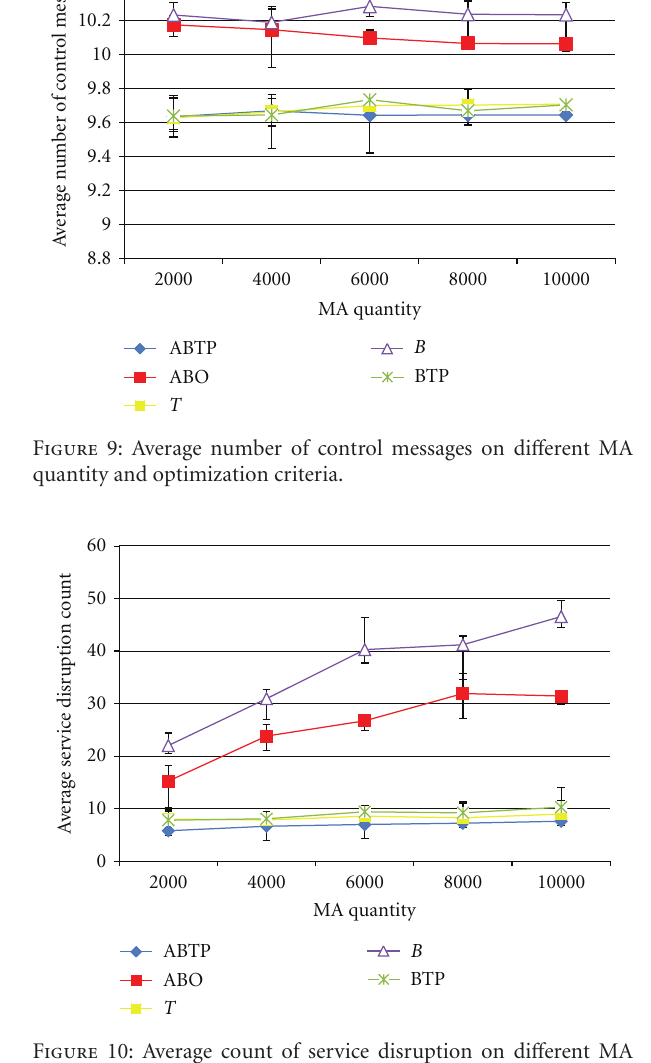
Figure 10: Average count of service disruption on di ff erent MA quantity and optimization